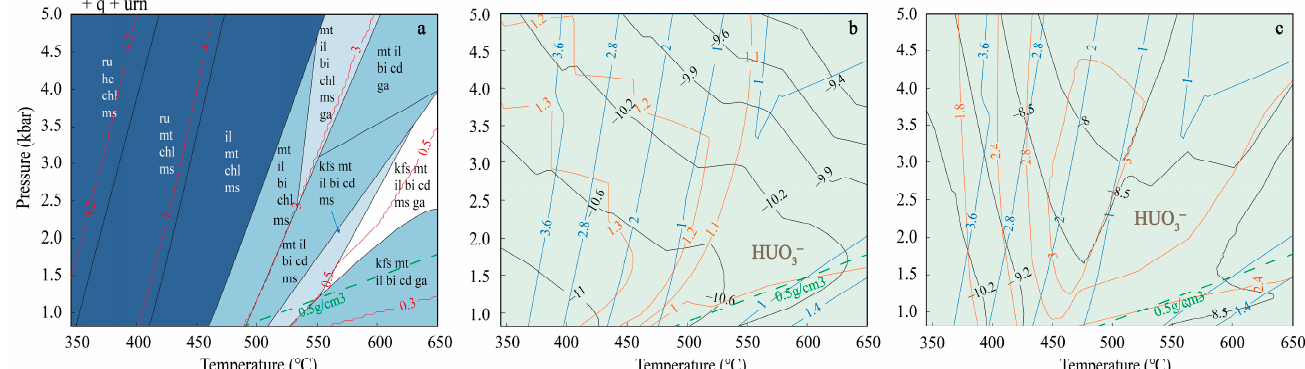
Figure 2. Results of thermodynamic simulation for fluids buffered by typical pelite. ( a ) P-T pseudo- section showing mineral assemblage and content of lithological bound water; ( b , c ) solubilities of uranium in pure water and 5 wt.% NaCl-H 2 O solution, respectively. The solubility of uranium is shown as logarithm of molality (black line), and the predominance fields of different uranium species are presented by different colors.The composition of typical pelite used for the simulation are shown in Table 1. The abbreviations of metamorphic facies: bi = biotite; cd = cordierite; ga = garnet; hem = hematite; il = ilmenite; kfs = K-feldspar; ms = muscovite; ru = rutile. The other abbreviations are the same as shown for Figure 1.